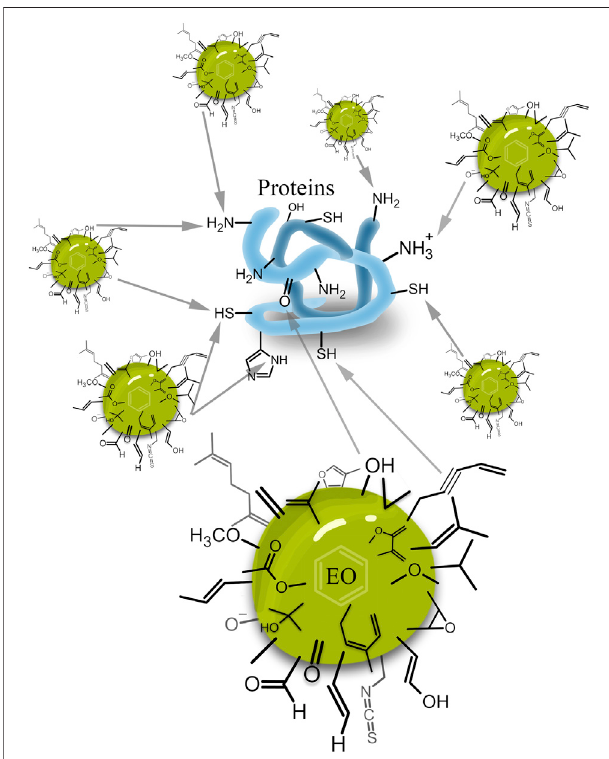
FIGURE 2 | EOs as MOCS and their potential multi-target interactions with